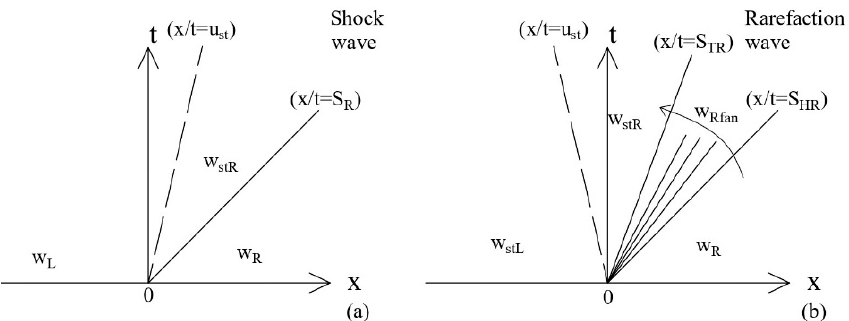
Figure A2. Solution of the Riemann problem to the right of the contact wave: ( a ) right wave is a shock wave; ( b ) right wave is a rarefaction wave.